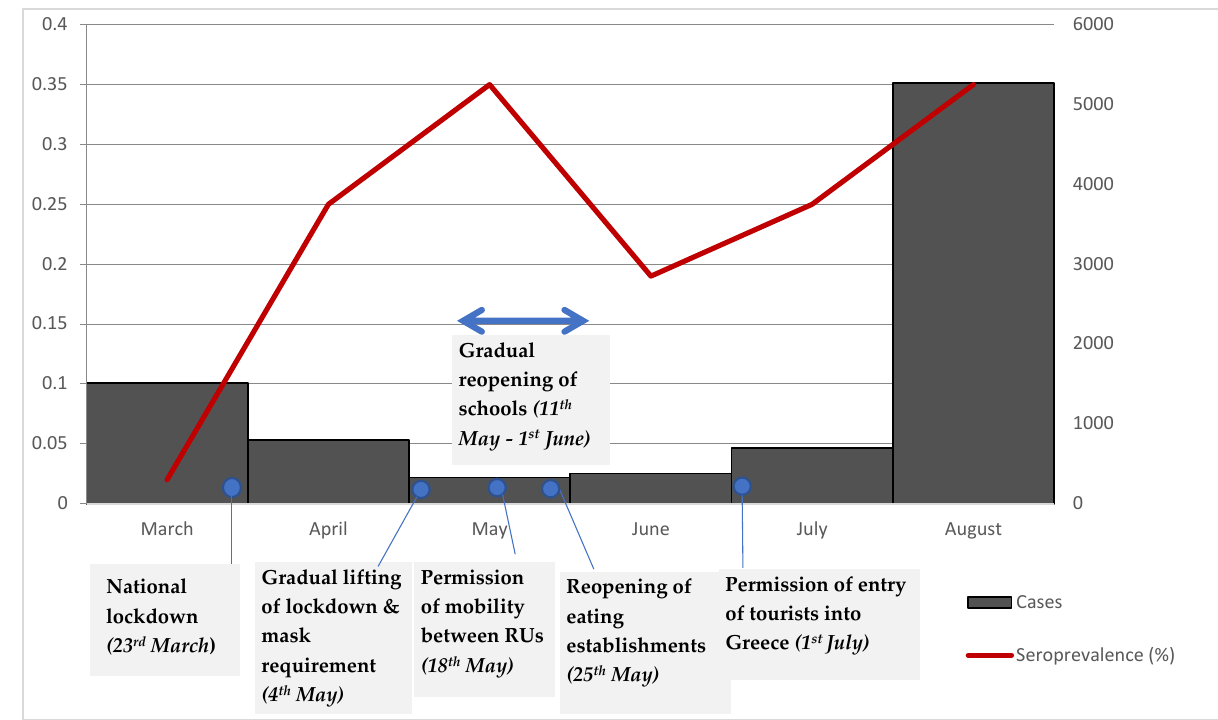
Figure 4. The seroprevalence, monthly cases and main public health measures in Greece during the period from March to